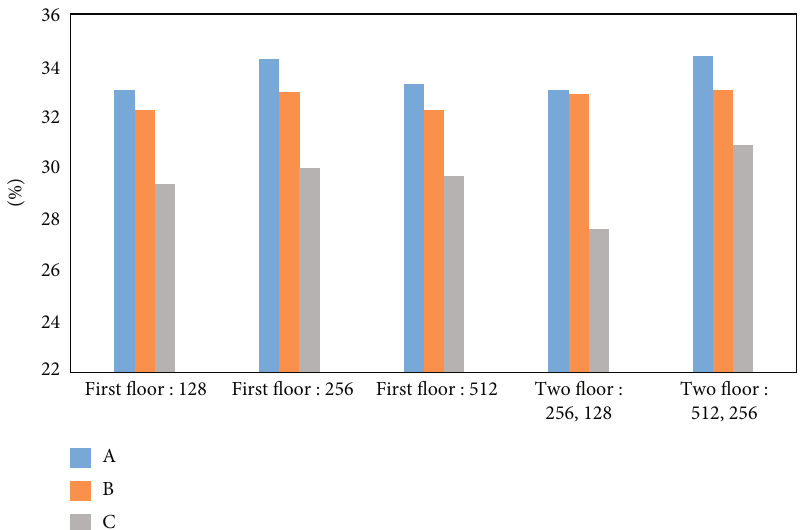
Figure 5: Experimental results of LSTM under di ff erent parameter states.